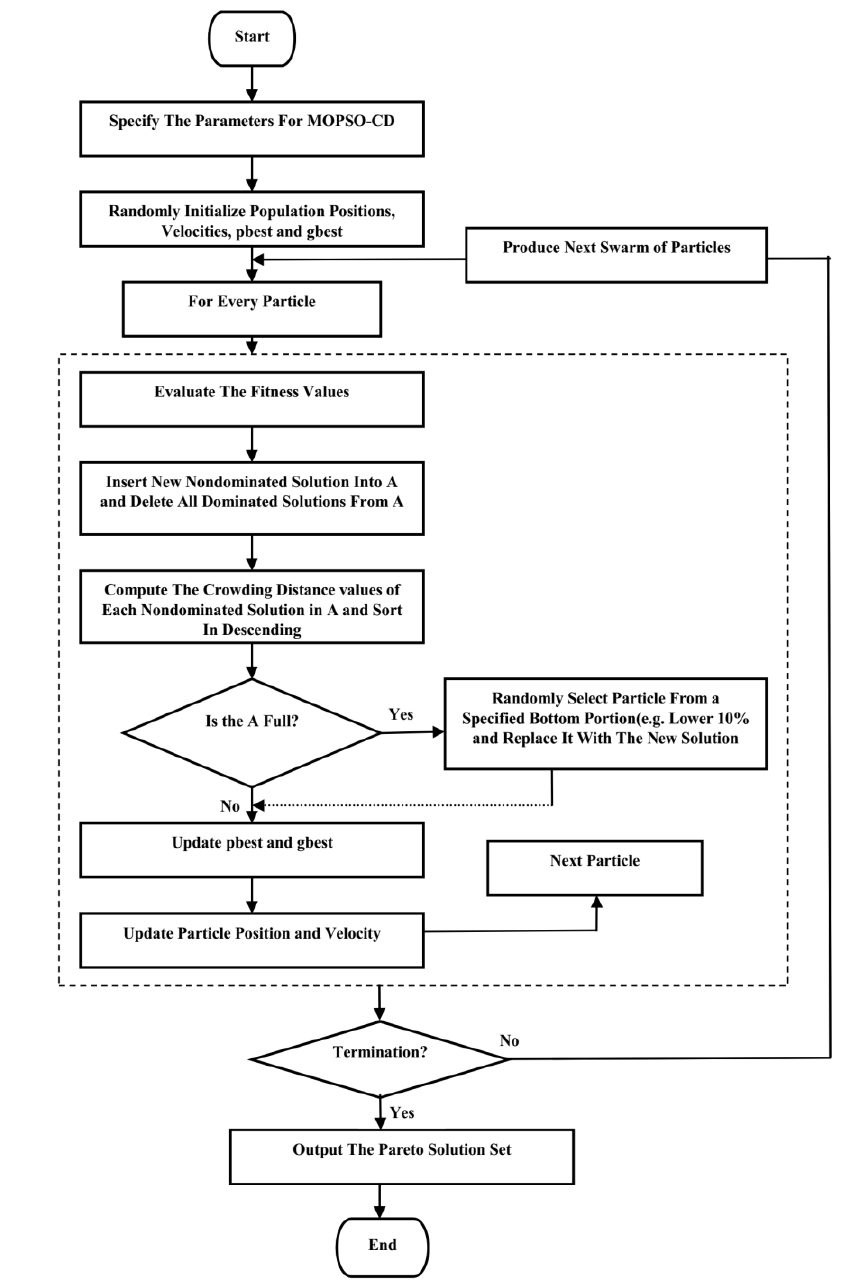
Figure 2. The flow chart of